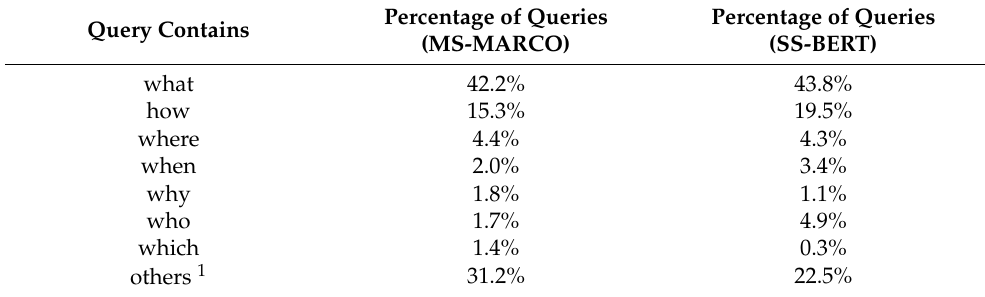
Table 2. The distribution of queries’ keywords of MS-MARCO and SS-BERT generated queries. Percentage of Queries Query Contains